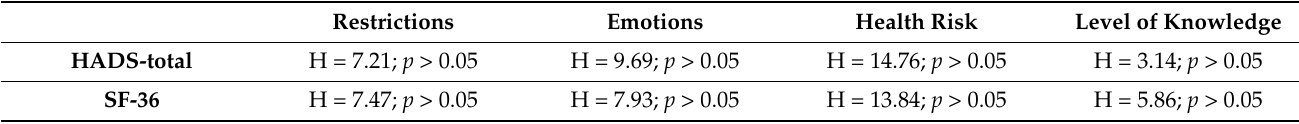
Table 2. Factors describing the situation of patients during the pandemic—statistical analysis—Kruskal-Wallis test. Restrictions Emotions Health Risk Level of Knowledge